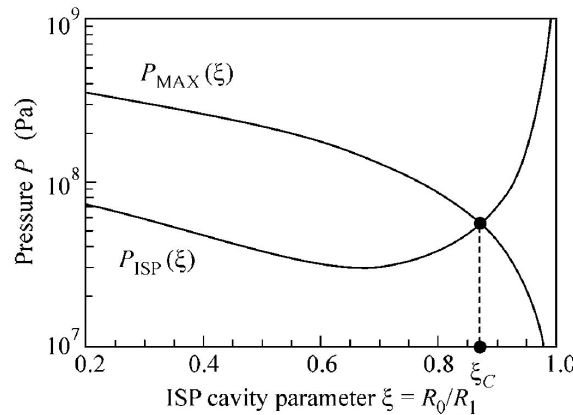
Figure 5: The critical parameter ξ (the ratio of the internal over ex- ternal radius) of a hollow ISP particle as determined by classical elasticity theory. For details, the reader can consult [10, 20, 24] and references quoted